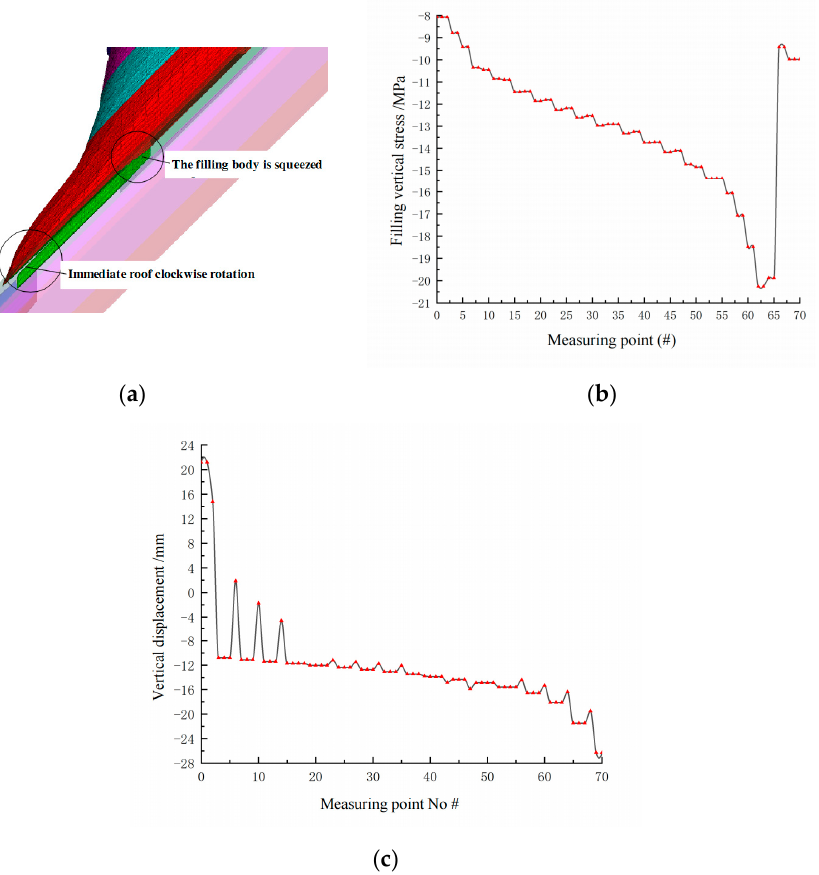
Figure 7. Bearing pressure distribution characteristics of filling. ( a ) Abutment pressure of filling, shows the immediate roof at the lower part of the gangue filling zone turned clockwise; ( b ) Vertical stress of the filling, and ( c ) Vertical displacement of filling, show the vertical stress and displacement of the filling, respectively.